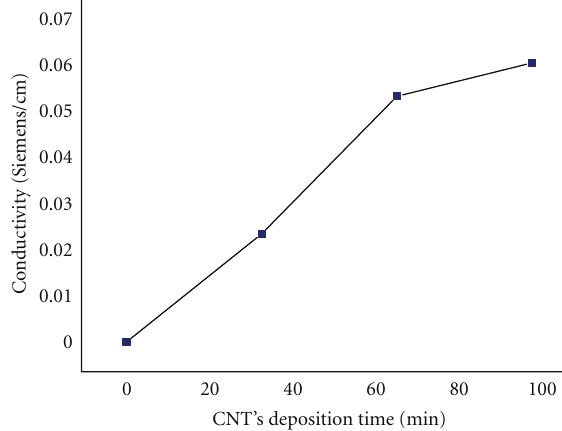
Figure 4: Room temperature conductivity of LiFePO 4 /CNT as a function of CNT deposition time.